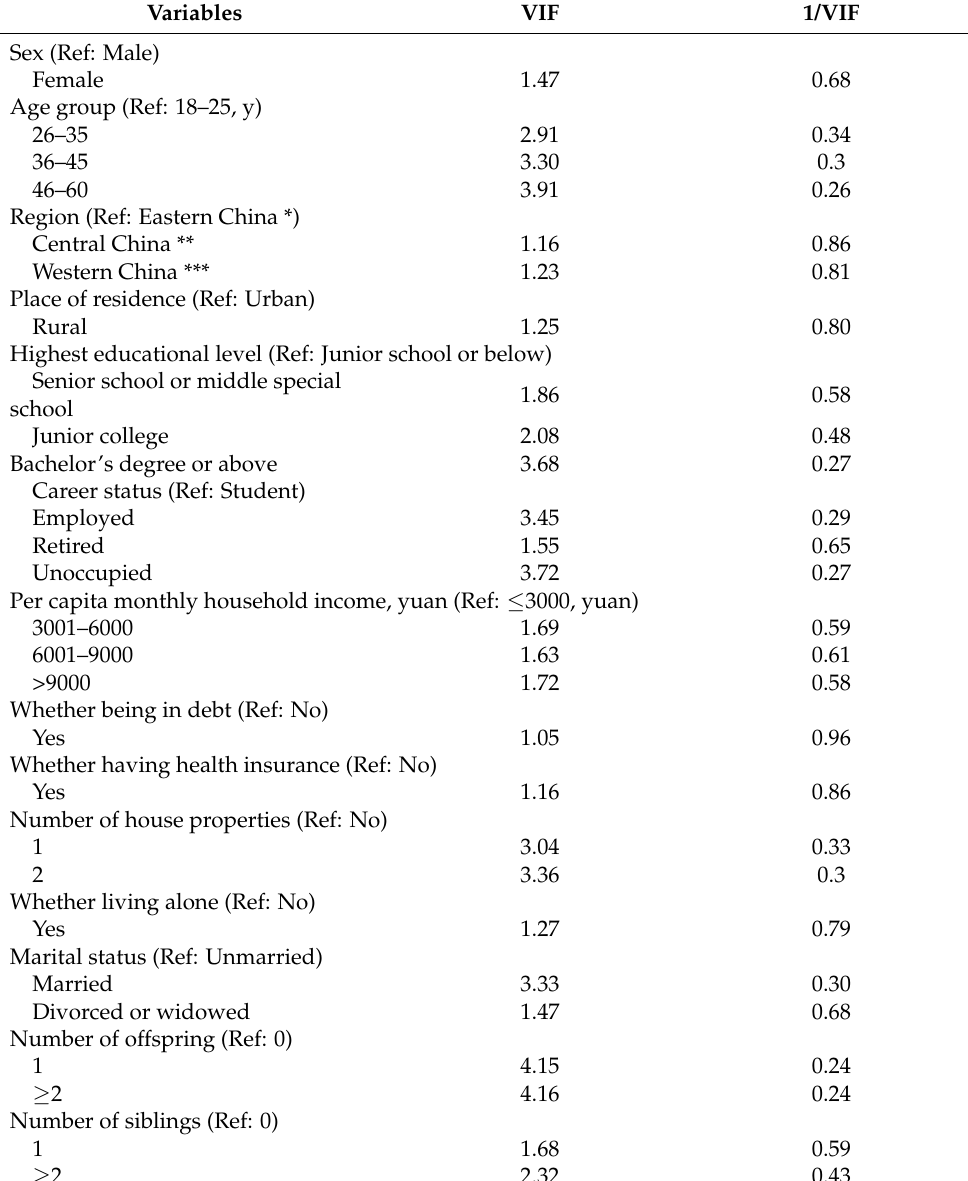
Table A2. The variance inflation factor of all variables in this